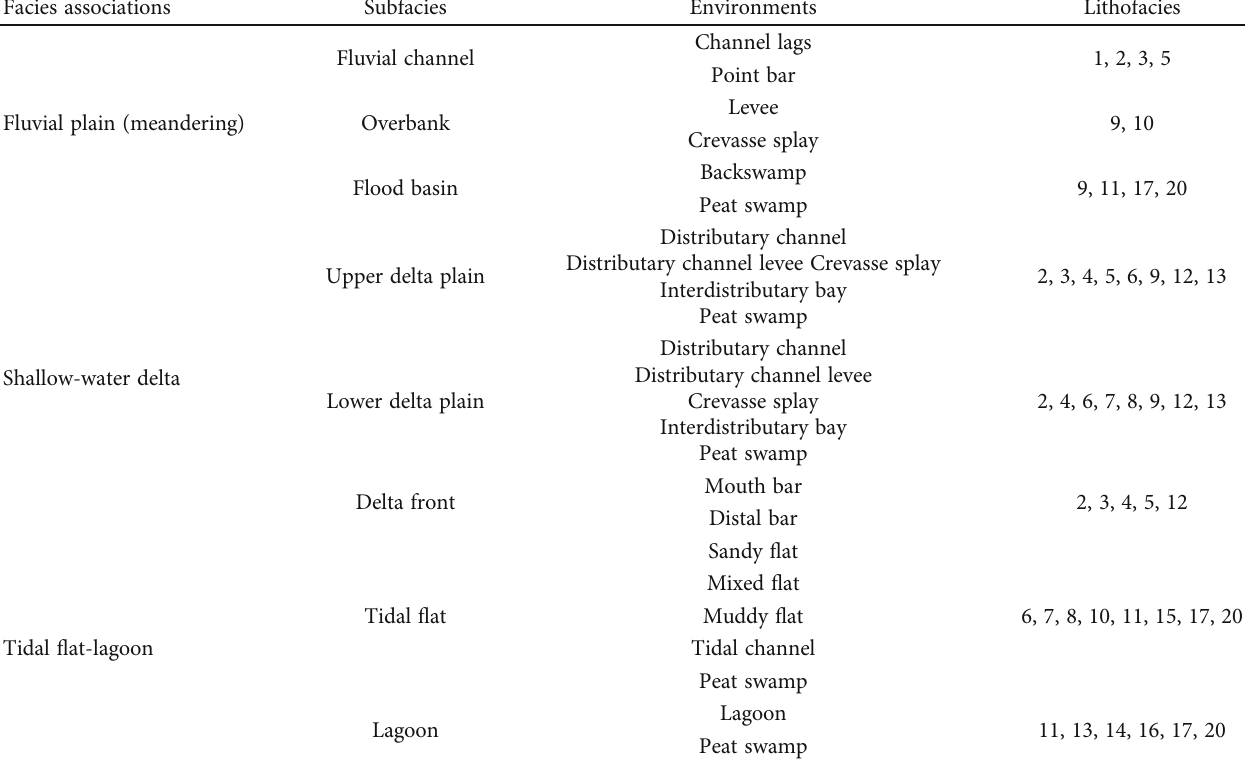
Table 2: Main depositional systems of the Lopingian coal-bearing rock system in southern